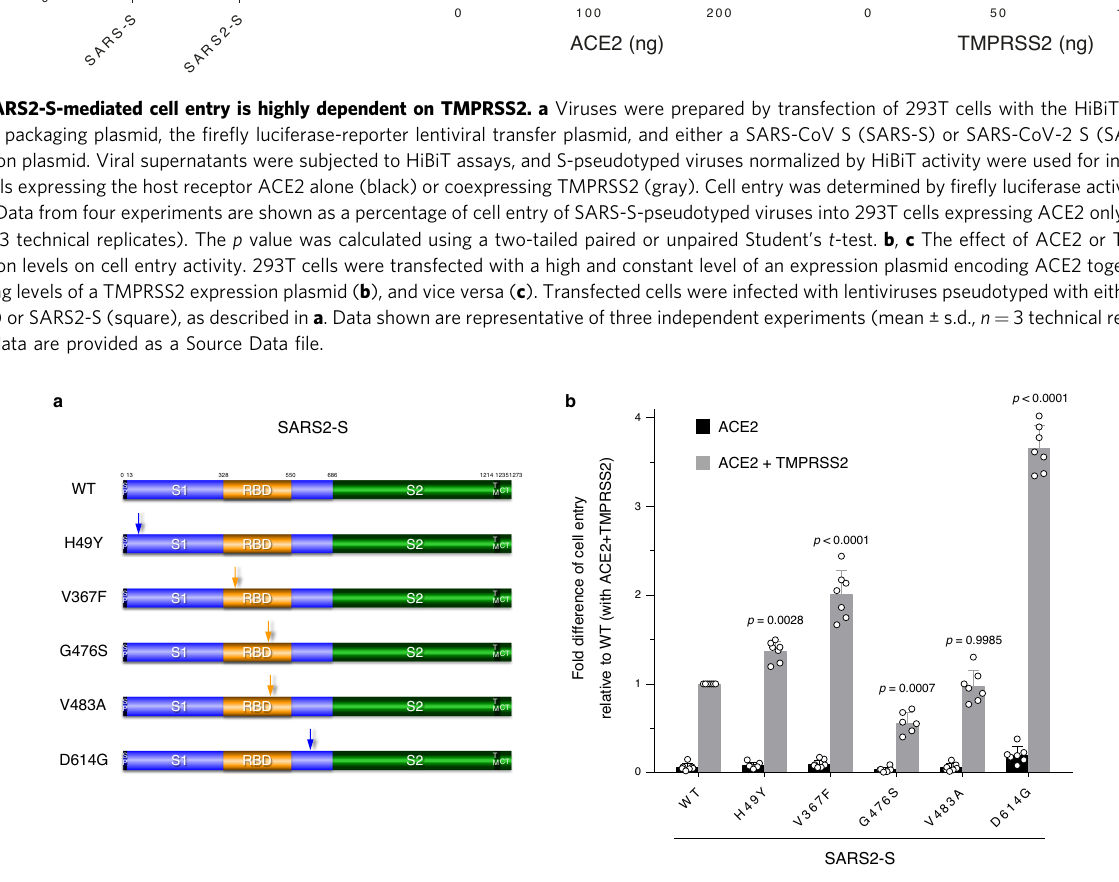
Fig. 2 SARS2-S D614G variant protein display highest levels of entry activity. a Schematic illustration of the prototype (wild-type, WT) and globally spread variant SARS2-S proteins. Numbers indicate amino acid positions. The signal peptide (SP), transmembrane domain (TM), cytoplasmic tail (CT), S1 subunit (S1), S2 subunit (S2), and receptor-binding domain (RBD) are indicated. The positions of mutations are indicated by arrows. b Functional comparison of the entry activity of WT and mutant SARS2-S proteins. Different S-pseudotyped viruses were prepared as described in a and used for infection of 293T cells expressing the host receptor ACE2 alone (black) or coexpressing TMPRSS2 (gray). Cell entry was determined by fi re fl y luciferase activity in cell lysates. Data were shown as the fold difference of cell entry relative to that of WT into 293T cells coexpressing ACE2 and TMPRSS2 (mean ± s.d. from seven independent experiments (except for that of G476S, n = 6 with three technical replicates); compared with WT using one-way ANOVA with Dunnett ’ s multiple comparison test. Source data for b are provided as a Source Data fi from the S2 subunit, and/or likely providing conformational fl ex- ibility to the overall structure of the S trimer, which might lead to improved af fi nity for ACE2. D614G protein binds ACE2 more ef fi ciently than WT protein .